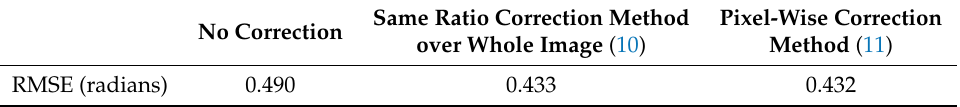
Table 2. Comparison of the captured image correction methods. We set the exposure time to be 33 µs × 10 iterations for each image (including 3 µs margin). We compared the estimated surface normals accuracy with a moving planar board which has a random dot textured surface. The distance between the image sensor and the scene is 1.25